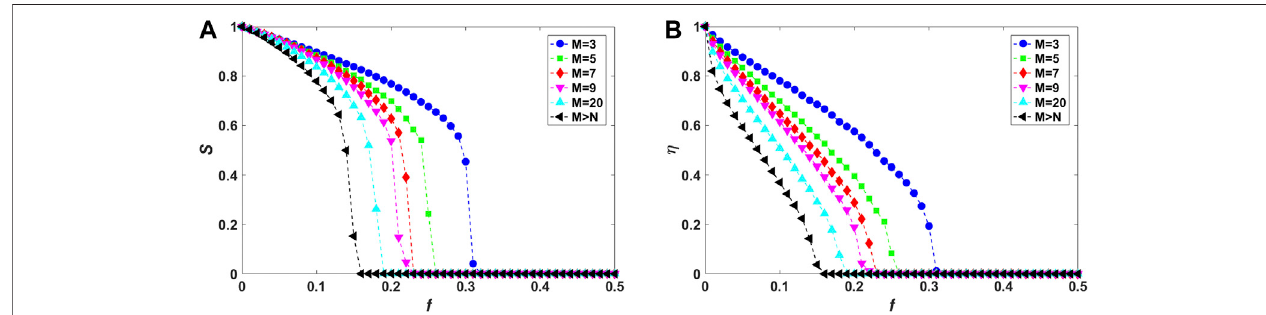
FIGURE 4 | (Color online) Vulnerability analysis of fully interdependent local-world networks (corresponding to interdependence strength q (cid:2) 1 . 0) after cascading failures caused by intentional removal of high-degree nodes from one network in the case of assortative interdependence. (A) Relative size S of the largest connected componentasafunctionofthefraction f ofremovednodes; (B) residualcommunicationef fi ciency η asafunctionofthefraction f ofremovednodes.Resultsareobtained by averaging over 50 independent realizations on interdependent systems consisting two local-world networks, which are separately constructed with N (cid:2) 2000, m (cid:2) 3, and 〈 k 〉 (cid:2) 2 m (cid:2) 6 for different M ( M (cid:2) 3 , 5 , 7 , 9 , 20 and M > N ).